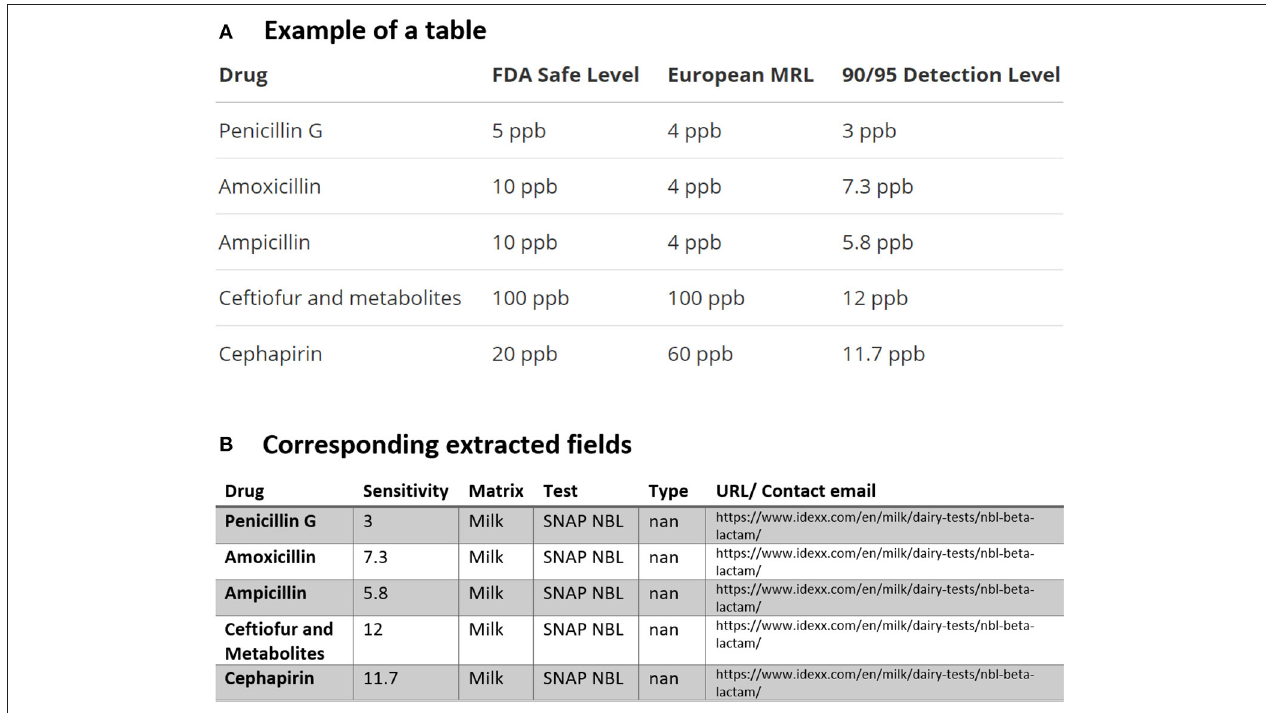
FIGURE 2 | An example of data table extraction for “SNAP NBL Test” (https://www.idexx.com/en/milk/dairy-tests/nbl-beta-lactam/) and the corresponding fields cleaned in a table.